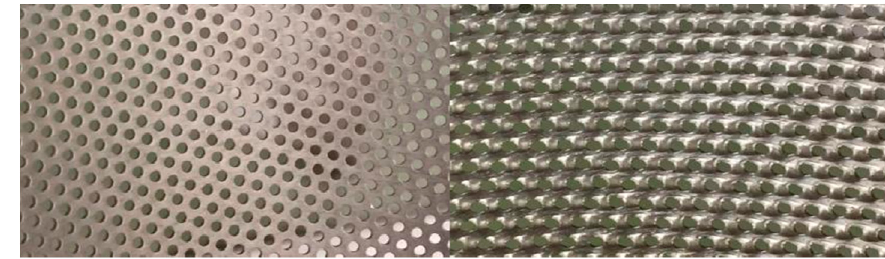
Figure 7. Normal screen (left), Grated Screen (right).